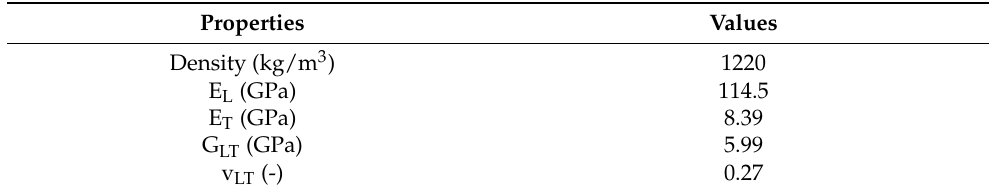
Table 4. Mechanical properties of UD carbon/epoxy